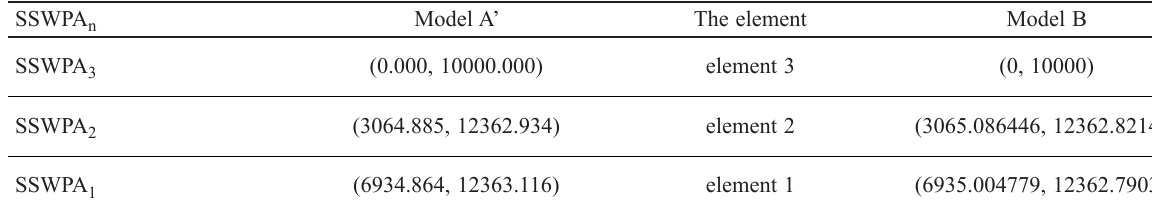
Table 5. Representation data to convert INP